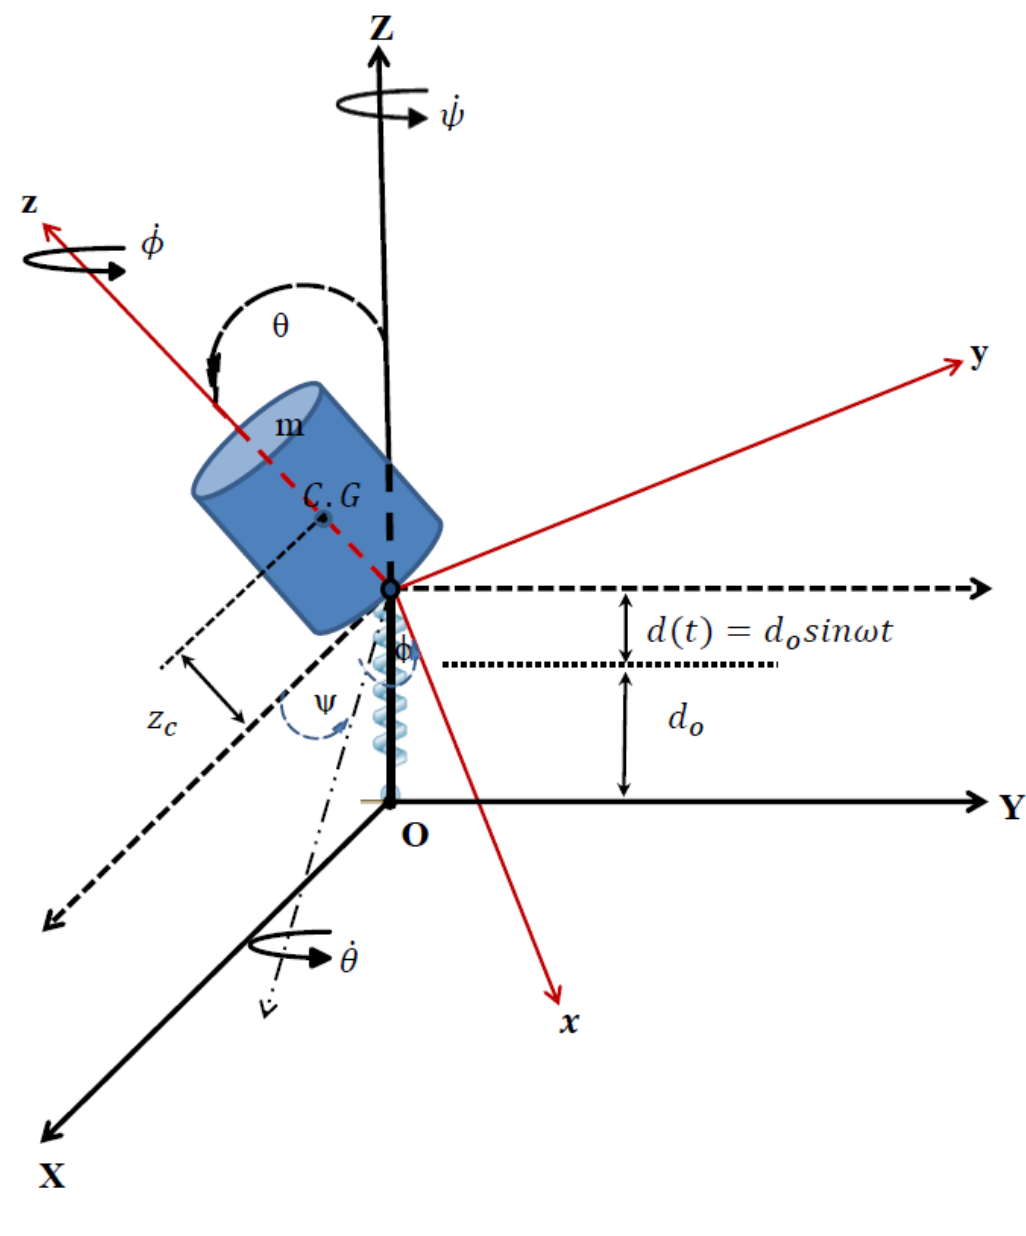
Fig. 1 Motion of Lagrange’s gyroscope represented by a cylindrical body mounted on a vibrating base with periodic excitation( d ( t ) = d o sin ω t